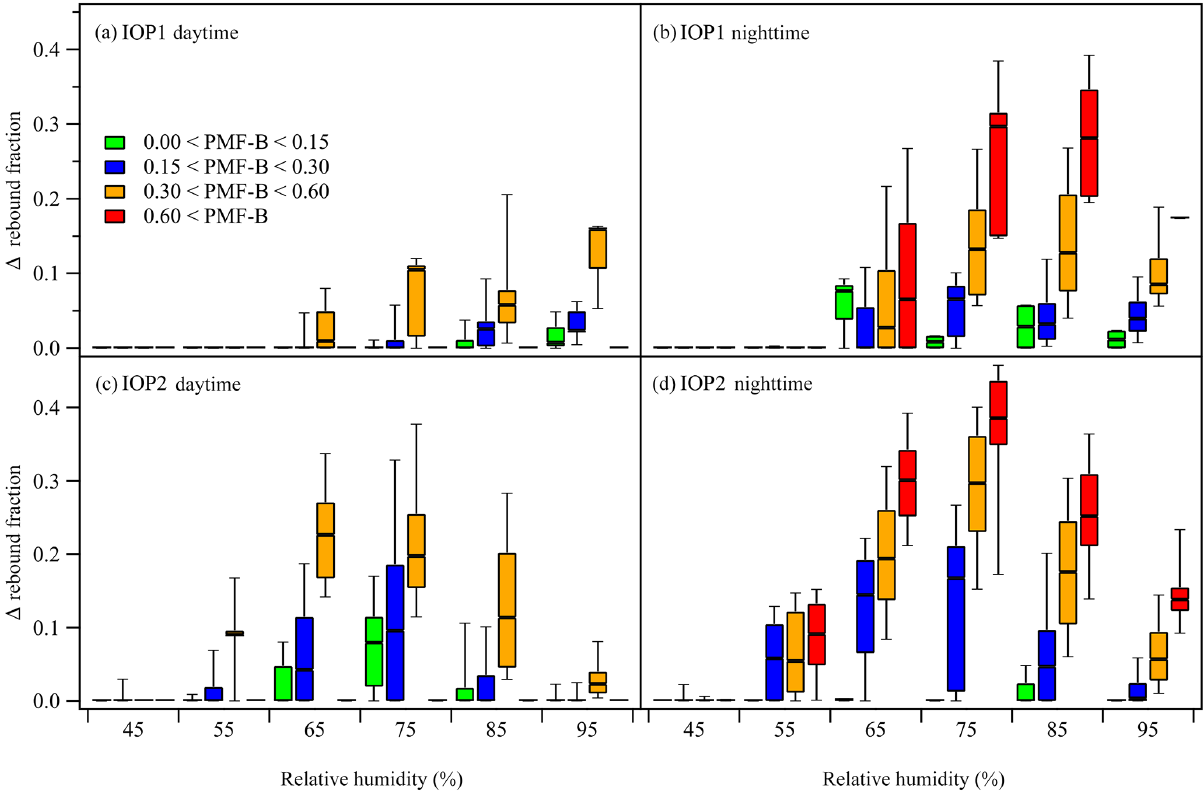
Figure 8. Deviation in rebound fraction for categorization by chemical characteristics. The box–whisker representation of the 10, 25, 50, 75, and 90% quantiles of rebound fraction is explained in the caption to Fig. 1. The chemical characteristics are categorized by the fractional loading of PMF group B as <0.15 (green), 0.15 to 0.3 (blue), 0.3 to 0.6 (orange), and >0.6